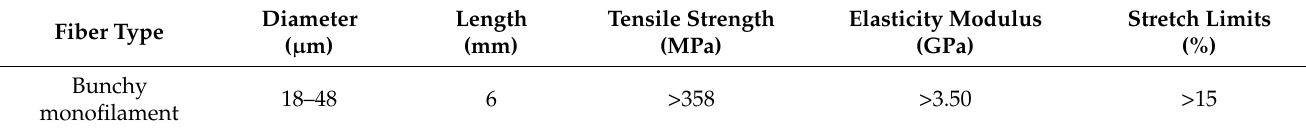
Table 2. Main technical indexes of polypropylene fiber [25].